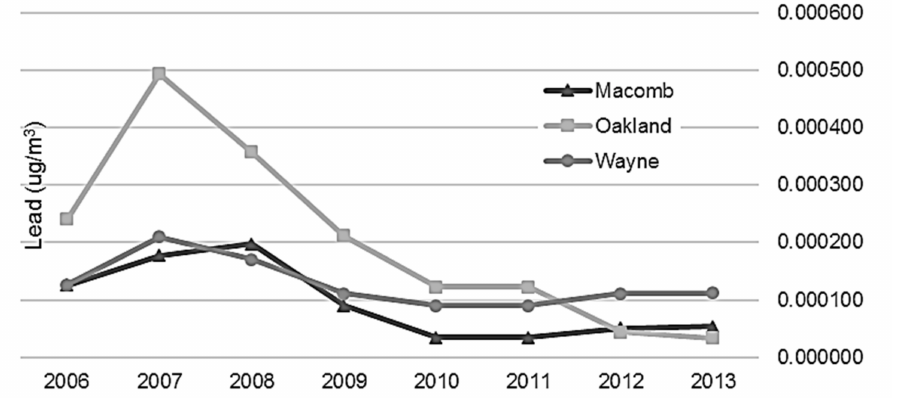
Figure 4. Average airborne lead concentration by county and year, Detroit Metropolitan Area, 2006–2013.